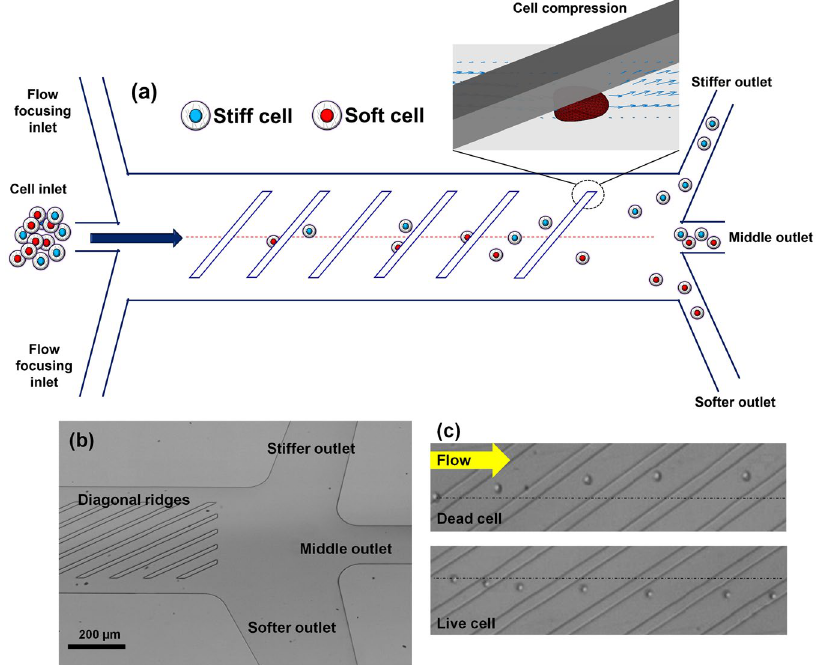
Figure 1. Ridge based microfluidic device for viable cell sorting. ( a ) Schematic representation of the device showing that cells will squeeze through ridges and flow towards different outlets based on their stiffness differences; ( b ) optical micrograph of the fabricated device showing the ridges and outlets; ( c ) representative micrograph of overlaid video of dead and live cells moving towards opposite directions in the device. The yellow arrow show the direction of fluid